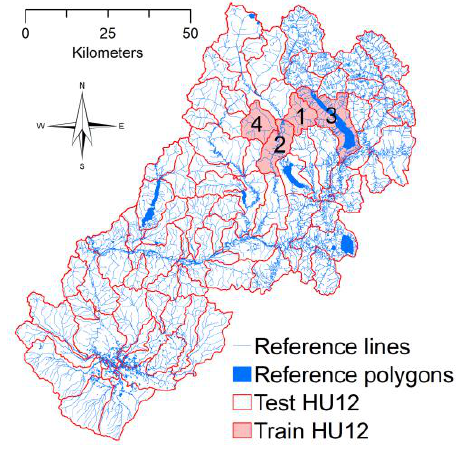
Figure 7. Vector reference hydrography with the four training watersheds numbered for the target study area domain.